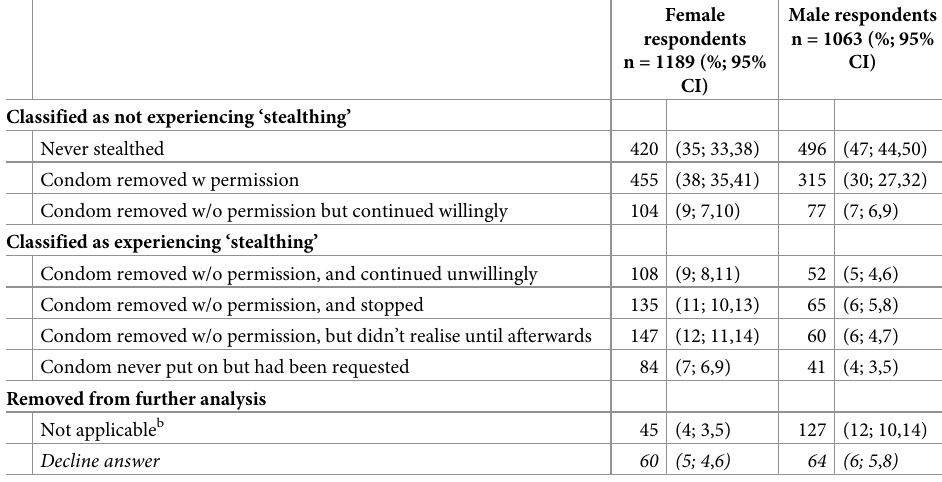
Table 2. Reported events of non-consensual removal of condoms (stealthing) amongst patients presenting to a STI clinic (N = 2252) a